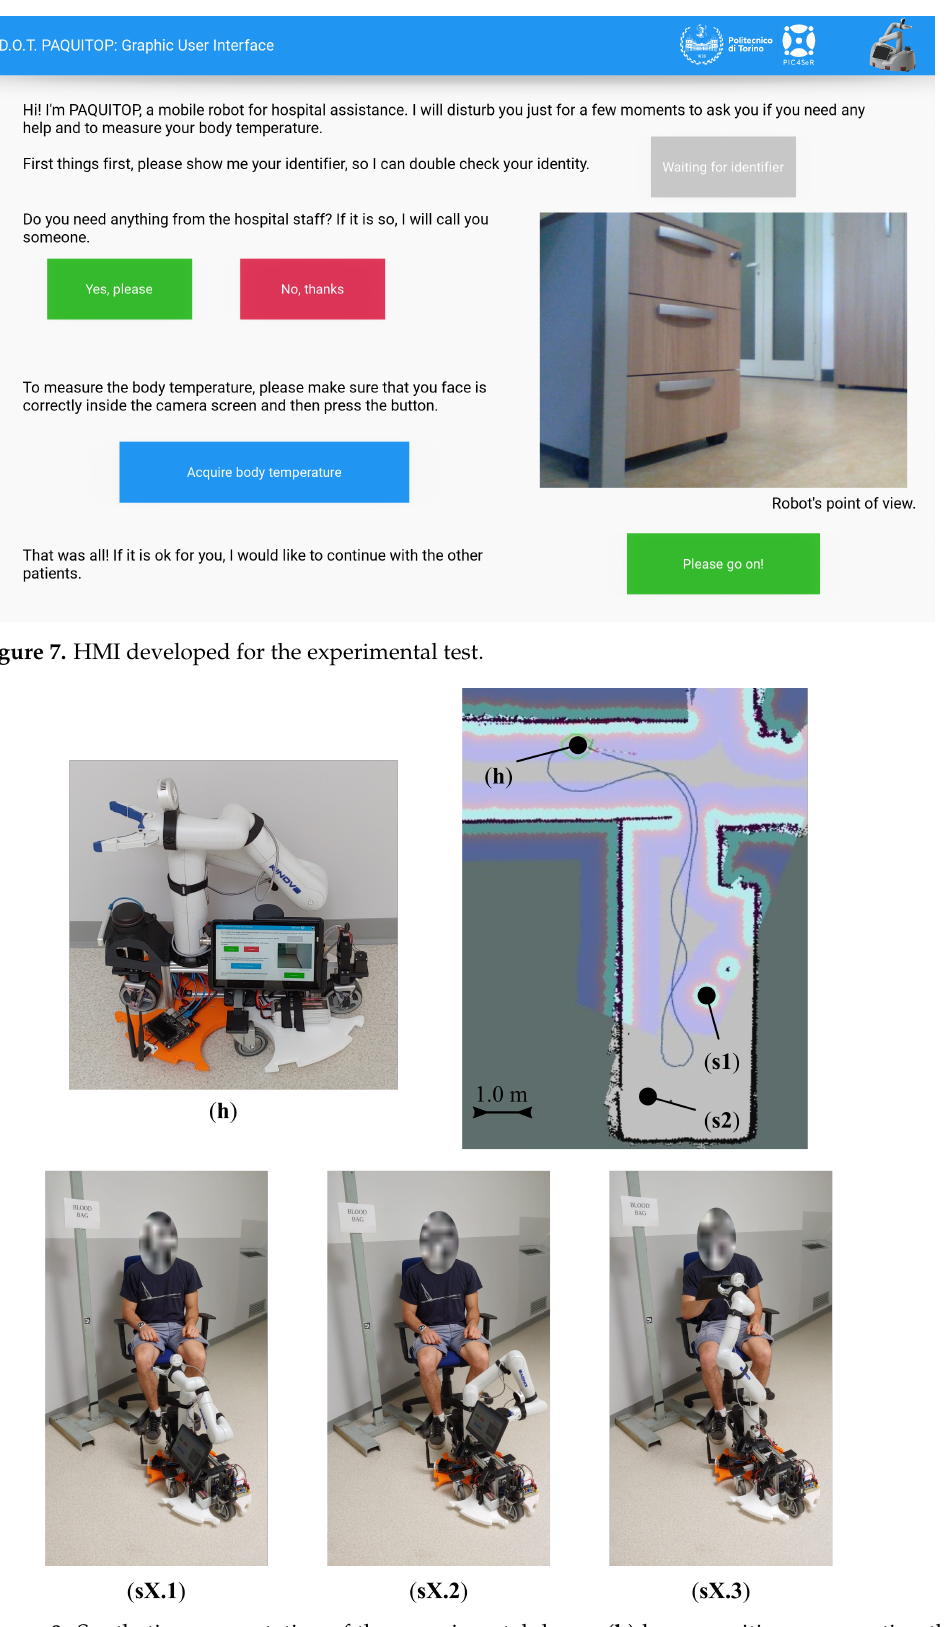
Figure 8. Synthetic representation of the experimental demo: ( h ) home position representing the future charging station; ( s1 ), ( s2 ) two stations for transfusion; ( sX.1 ) the robot detects the blood bag identifier; ( sX.2 ) the robot deploys the HMI towards the user; ( sX.3 ) the robot performs the matching check and interacts with the patient through the